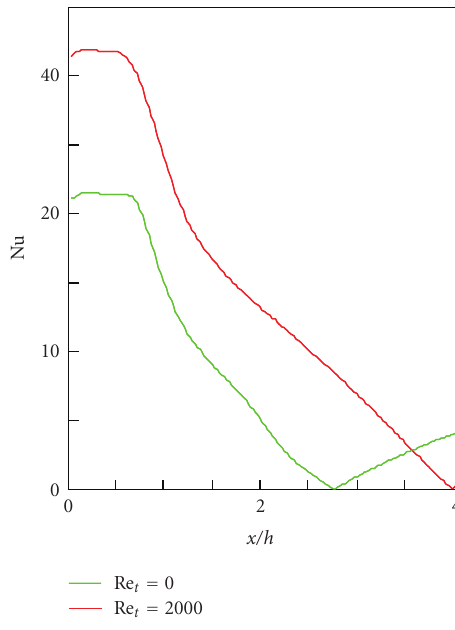
Figure 8: Local Nusselt Number on the rotating disk surface for Re = 360 and h/D i = 0 . 1.